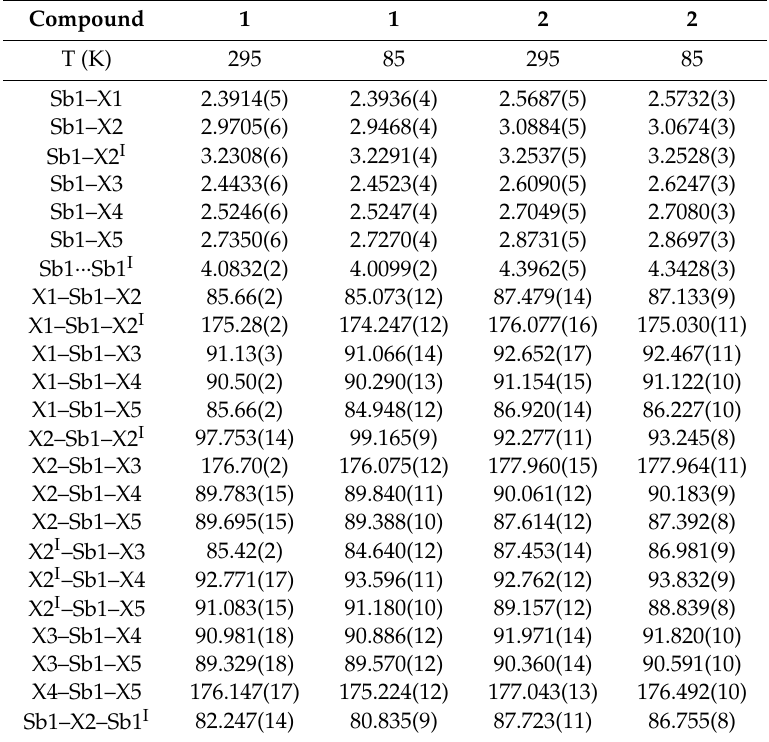
Table 2. Selected bond lengths (Å) and angles ( ◦ ) for 1 (X = Cl) and 2 (X = Br) at 295 and 85 K. Compound